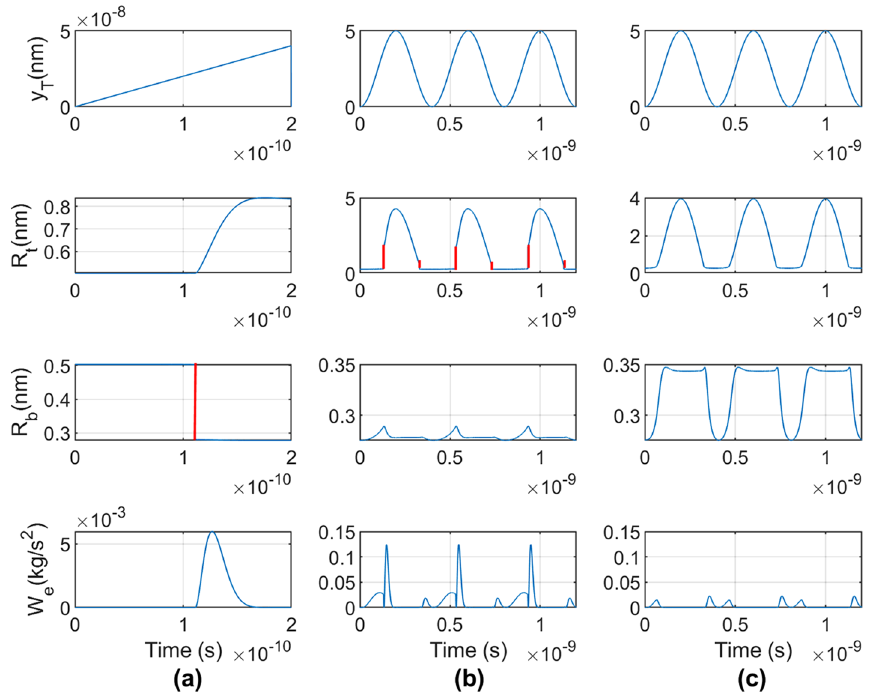
Figure 2. Displacement input y T and resulting response R t and R b , and kinetic energy W e of the model. ( a ) Sinusoidal input displacement at 80 Hz (appears linear over this very short time); ( b ) sinusoidal input at